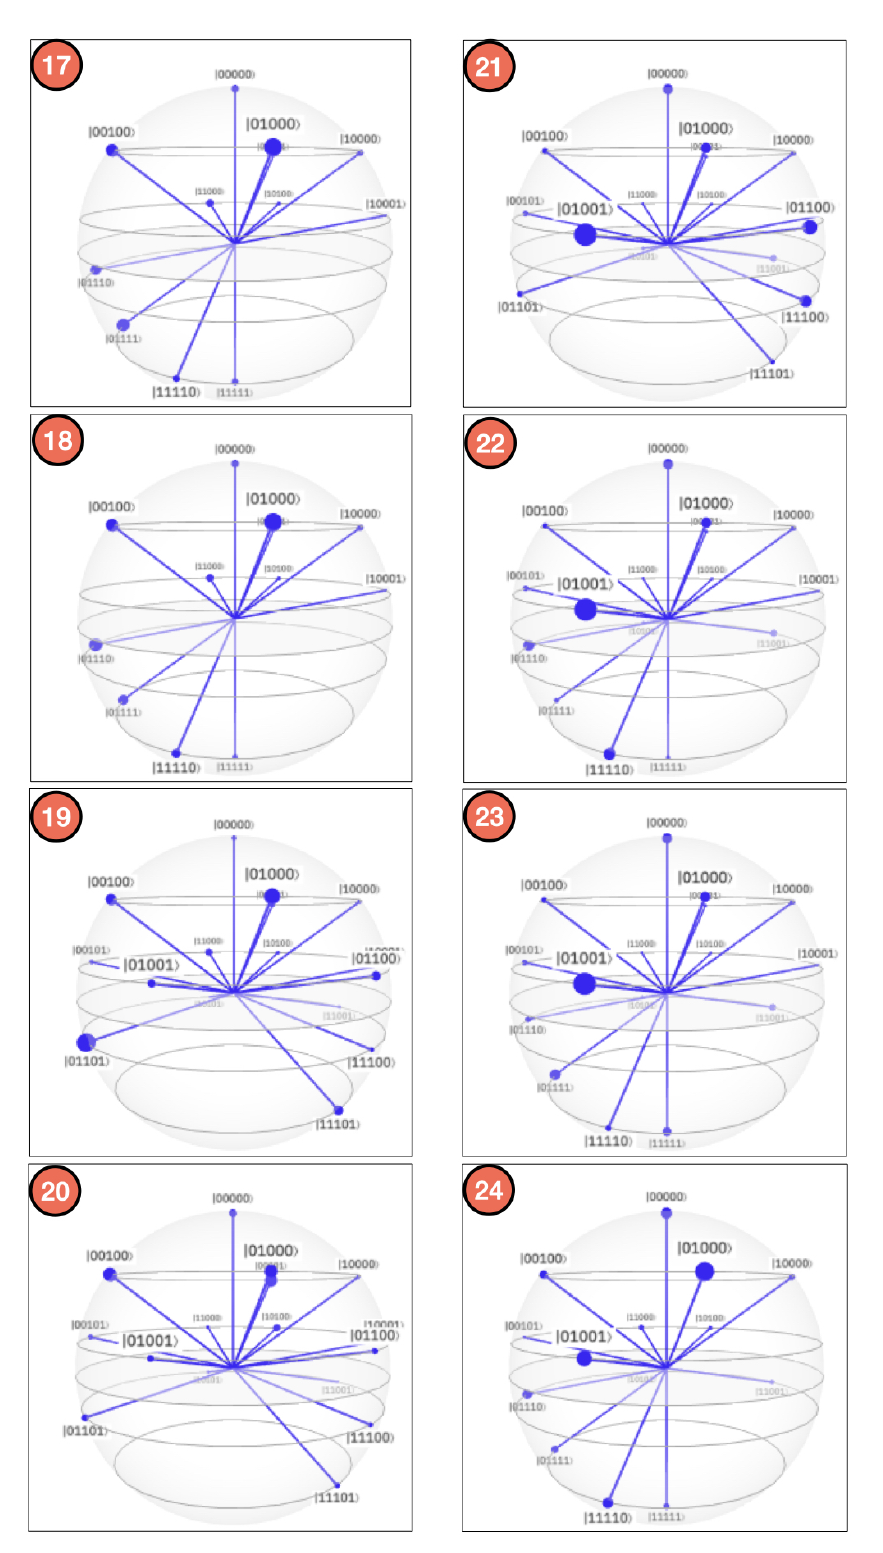
Figure A3. QSOD Bloch sphere measurements steps